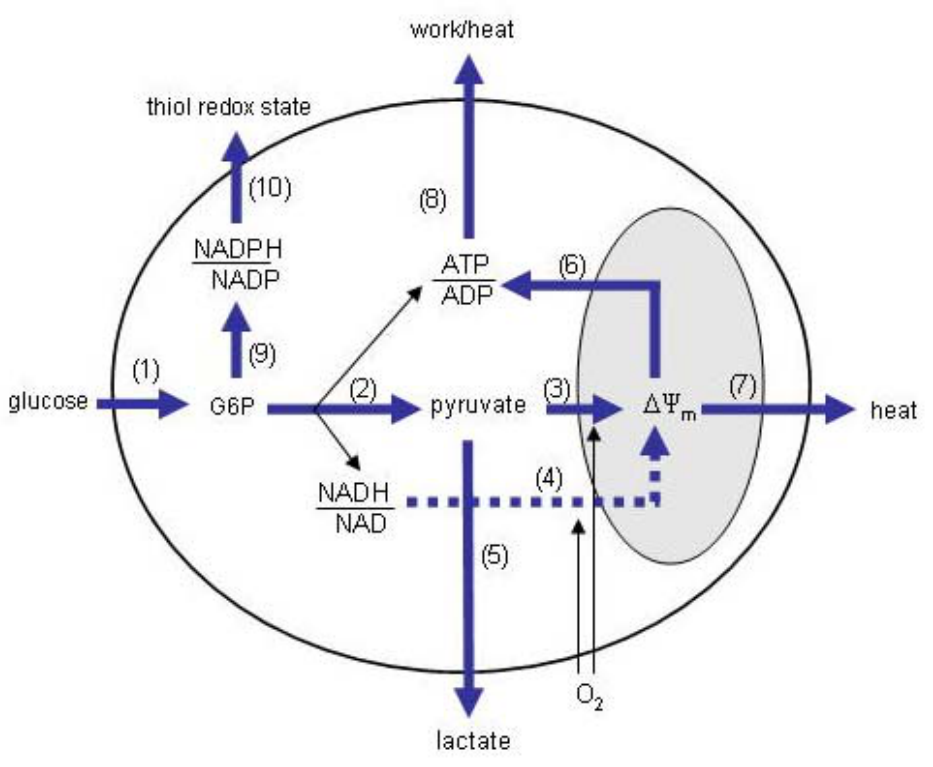
Figure 1. A simplified model of energy metabolism. Reactions involved in producing and consuming ATP have been grouped into 10 blocks separated by 6 intermediates. The blocks are numbered as (1) glucose transport and phosphorylation (GTP), (2) glycolysis (GLY), (3) pyruvate oxidation (PYR), (4), NADH oxidation (NAO), (5) lactate production (LAC), (6) mitochondrial phosphorylating system (PHO), (7) mitochondrial H + leak (PRL), (8) ATP consumers (ATC), (9) pentose phosphate pathway (PPP), and (10) NADPH oxidation (NPO). G6P: glucose-6-phosphate; ΔΨ membrane